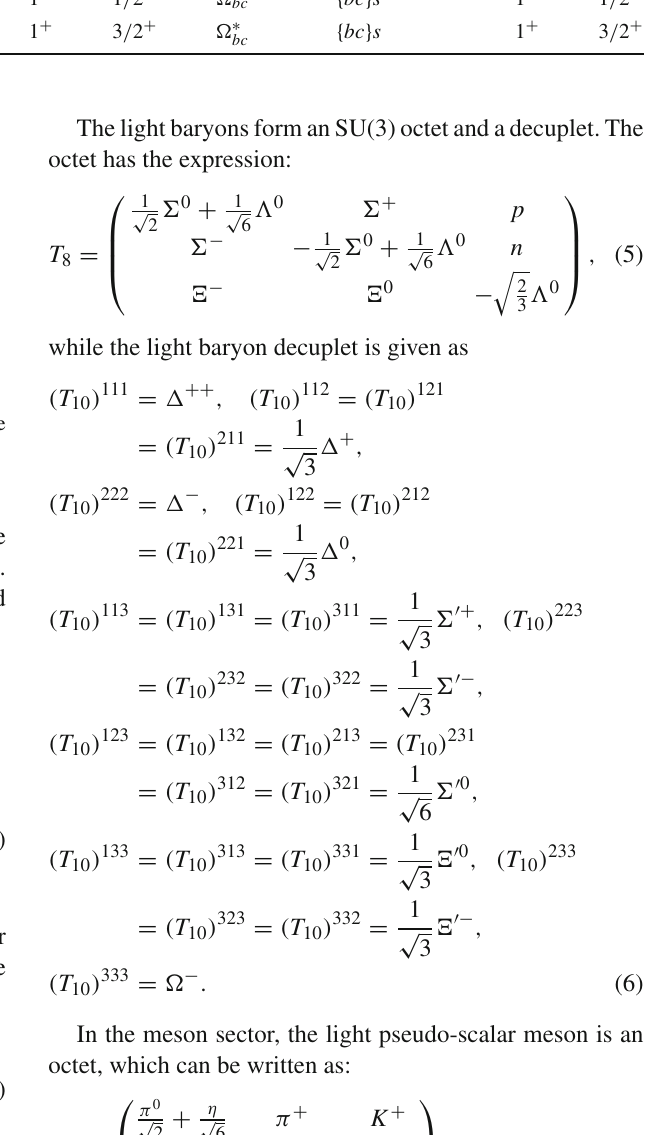
Table 1 Quantum numbers for the ground state of doubly heavy baryons. The light quark q corresponds to u , d quark. The J P denotes the total spin and parity of the baryons. The label S π corresponds to the spin of h the heavy quark system